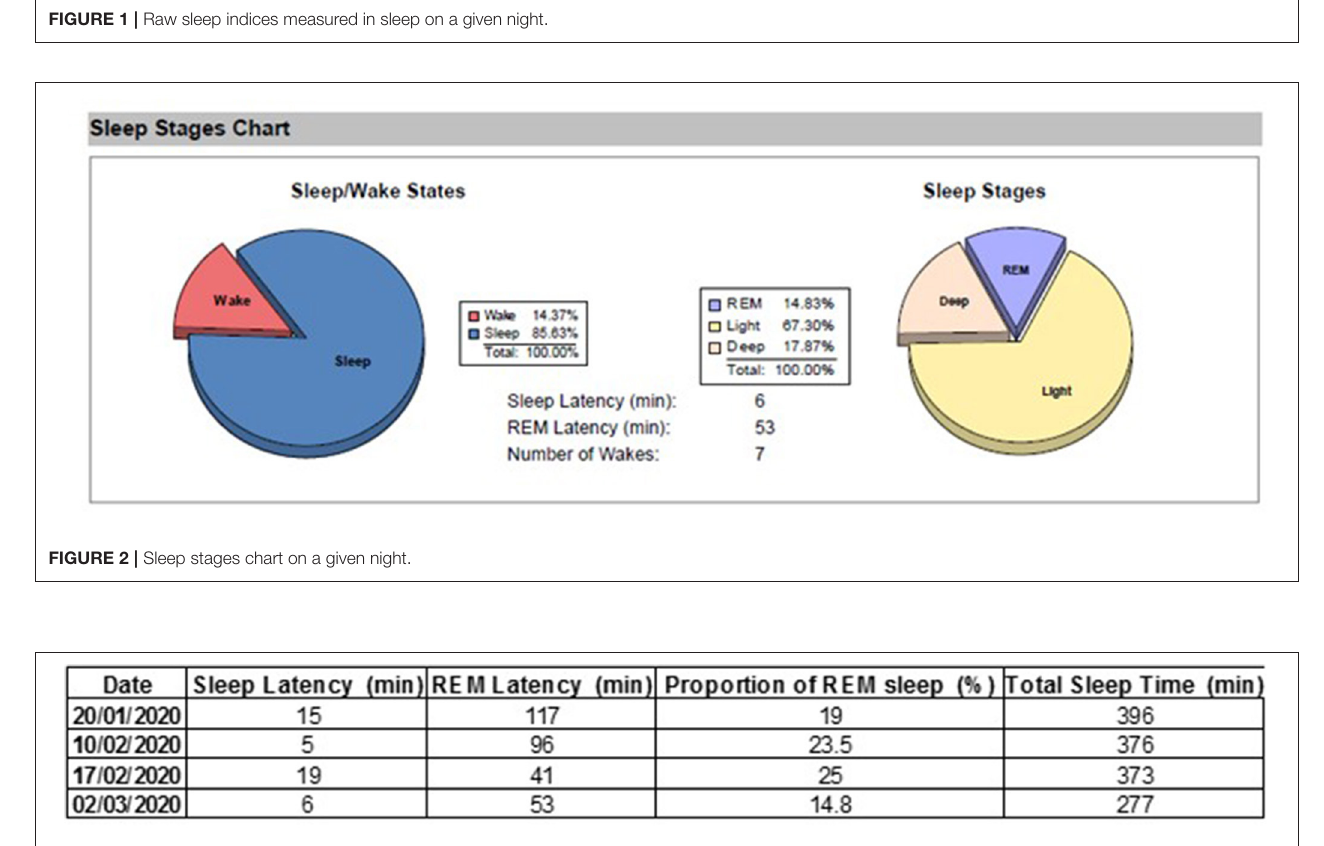
FIGURE 3 | Sleep indices measured during the